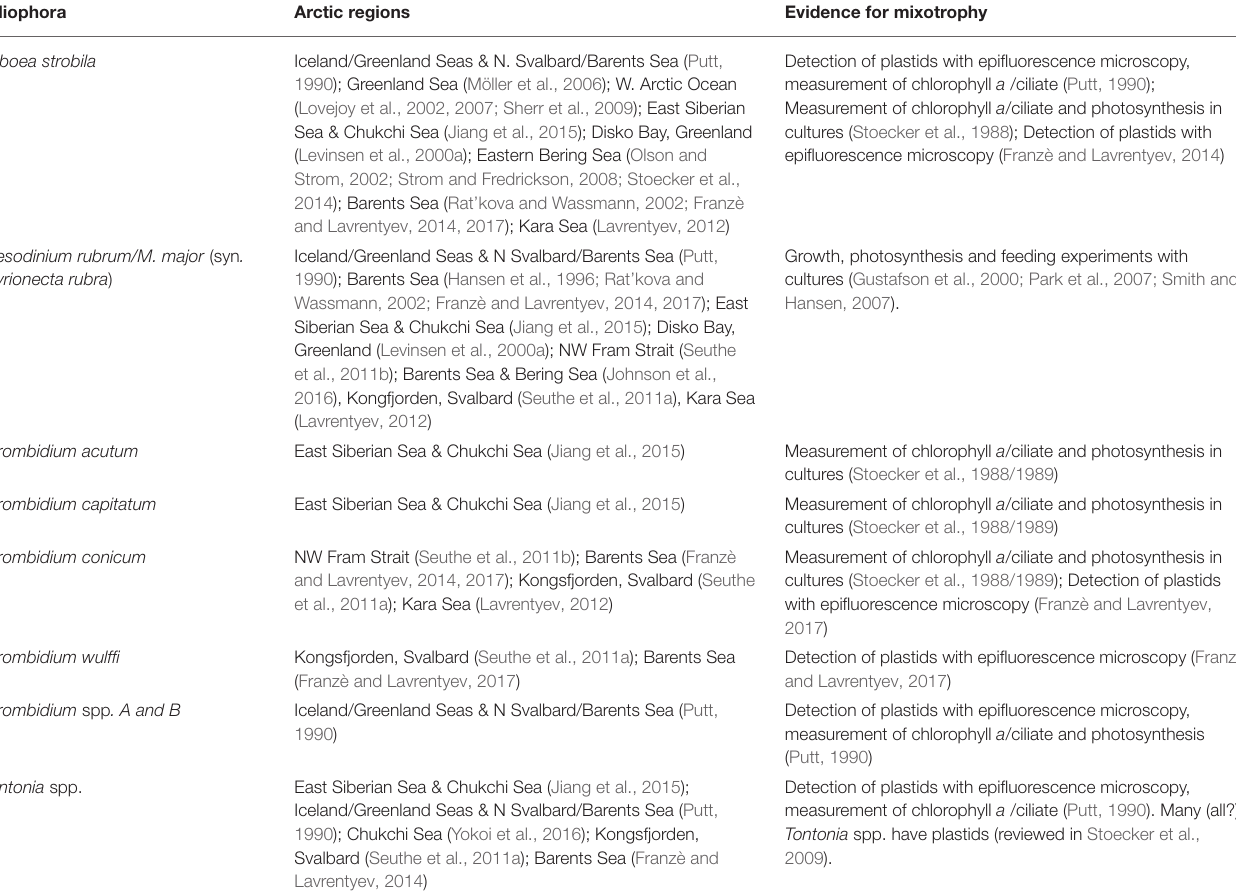
TABLE 2 | Common mixotrophic ciliates in the